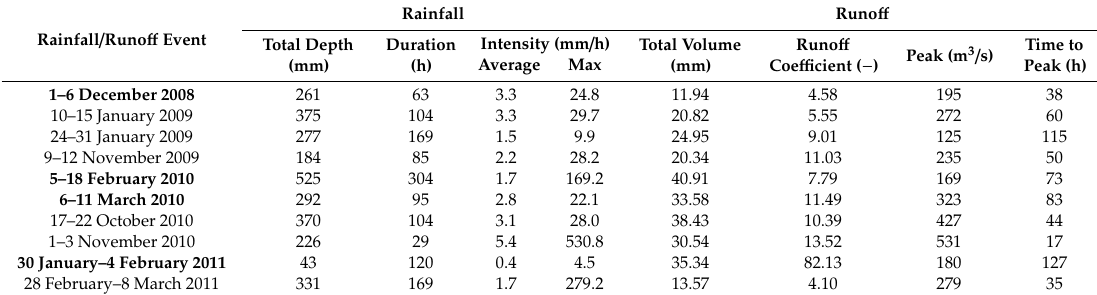
Table 2. Hydrological characterisation of the 10 rainfall–runo ff events used for model verification in the Mesima torrent (Calabria, Southern